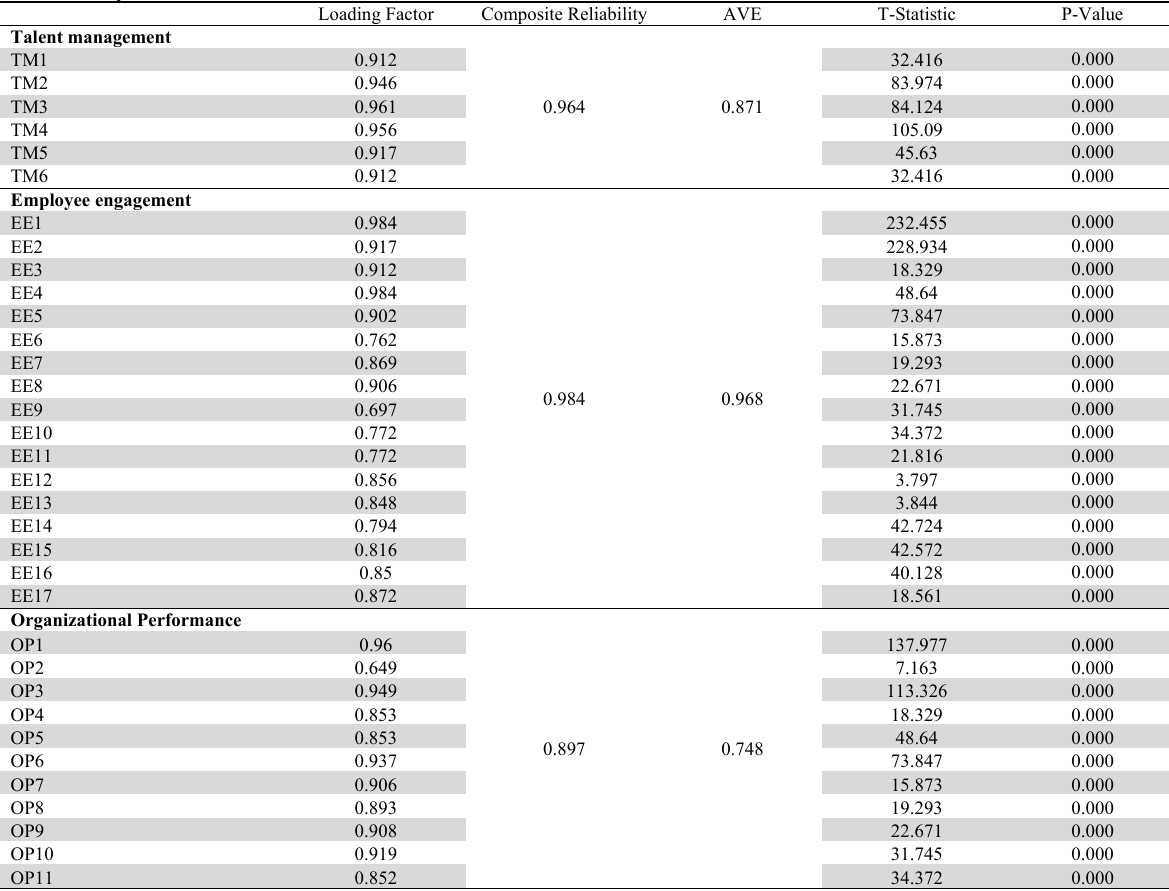
The summary of measured